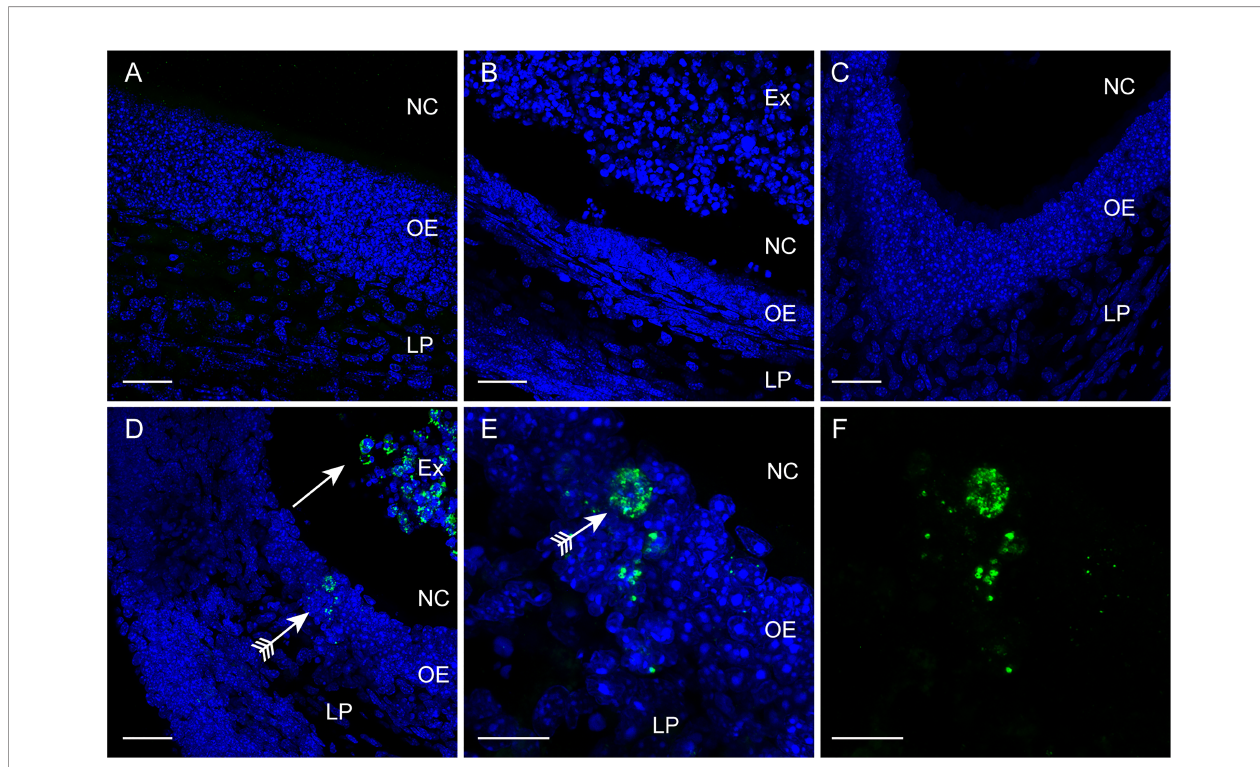
FIGURE 2 | Immunolabelling for S. agalactiae in the olfactory mucosa. Panels show confocal microscopy images of the olfactory mucosa with immunolabelling for S. agalactiae (green), and nuclei stained with DAPI (blue) 24 h post intranasal inoculation with the bacteria or vehicle. (A) Control, vehicle-only (PBS ! PBS) treatment. The olfactory epithelium (OE) and lamina propria (LP) constitute the olfactory mucosa. NC: nasal cavity. (B) Methimazole treatment only (methimazole ! PBS). The OE has been degraded and is sloughing off as an exudate (Ex) into the NC. (C) Intranasal inoculation with S. agalactiae (PBS ! S. agalactiae ). No S. agalactiae bacteria were detected within the OE. (D) Methimazole treatment followed by intranasal S. agalactiae inoculation (methimazole ! S. agalactiae ). S. agalactiae bacteria were detected in the Ex (arrow) and in the OE (arrow with tail). (E, F) Higher magni fi cation view of the OE shown in (D) ; (F) S. agalactiae immunolabelling alone. Scale bar: 30 m m in (A – D) ; 10 m m in (E, F)